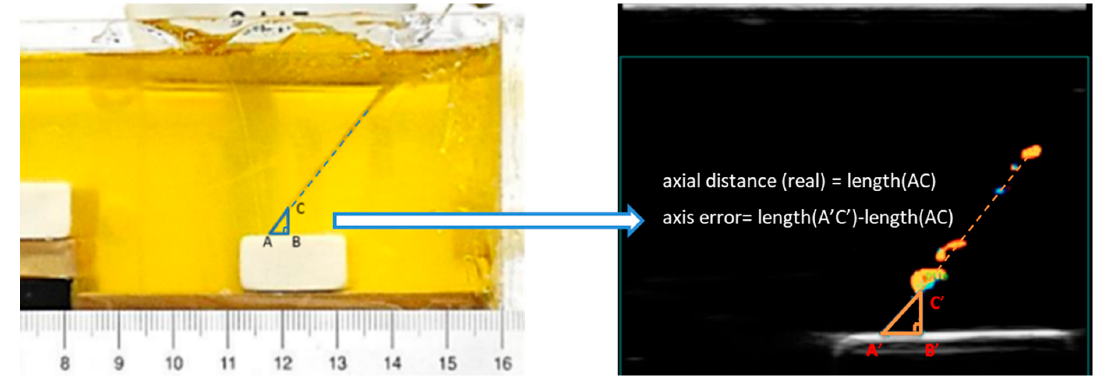
Figure 3. Paired measurements of the distance from the needle tip to the rubber target in the photograph and Doppler ultrasound image. Side AC of the right triangle ABC in the photograph is the real axial distance, the axis error equals the difference between length (A’C’) and length (AC). 2.5. Needle Accuracy Test: Color Doppler vs. Greyscale